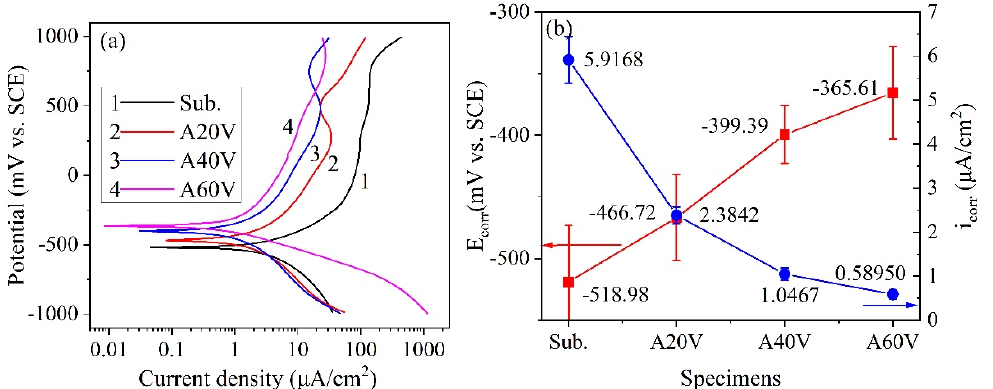
Figure 7. Potentiodynamic polarization curves ( a ) and corrosion parameters (E corr and i corr ) ( b ) of various specimens.